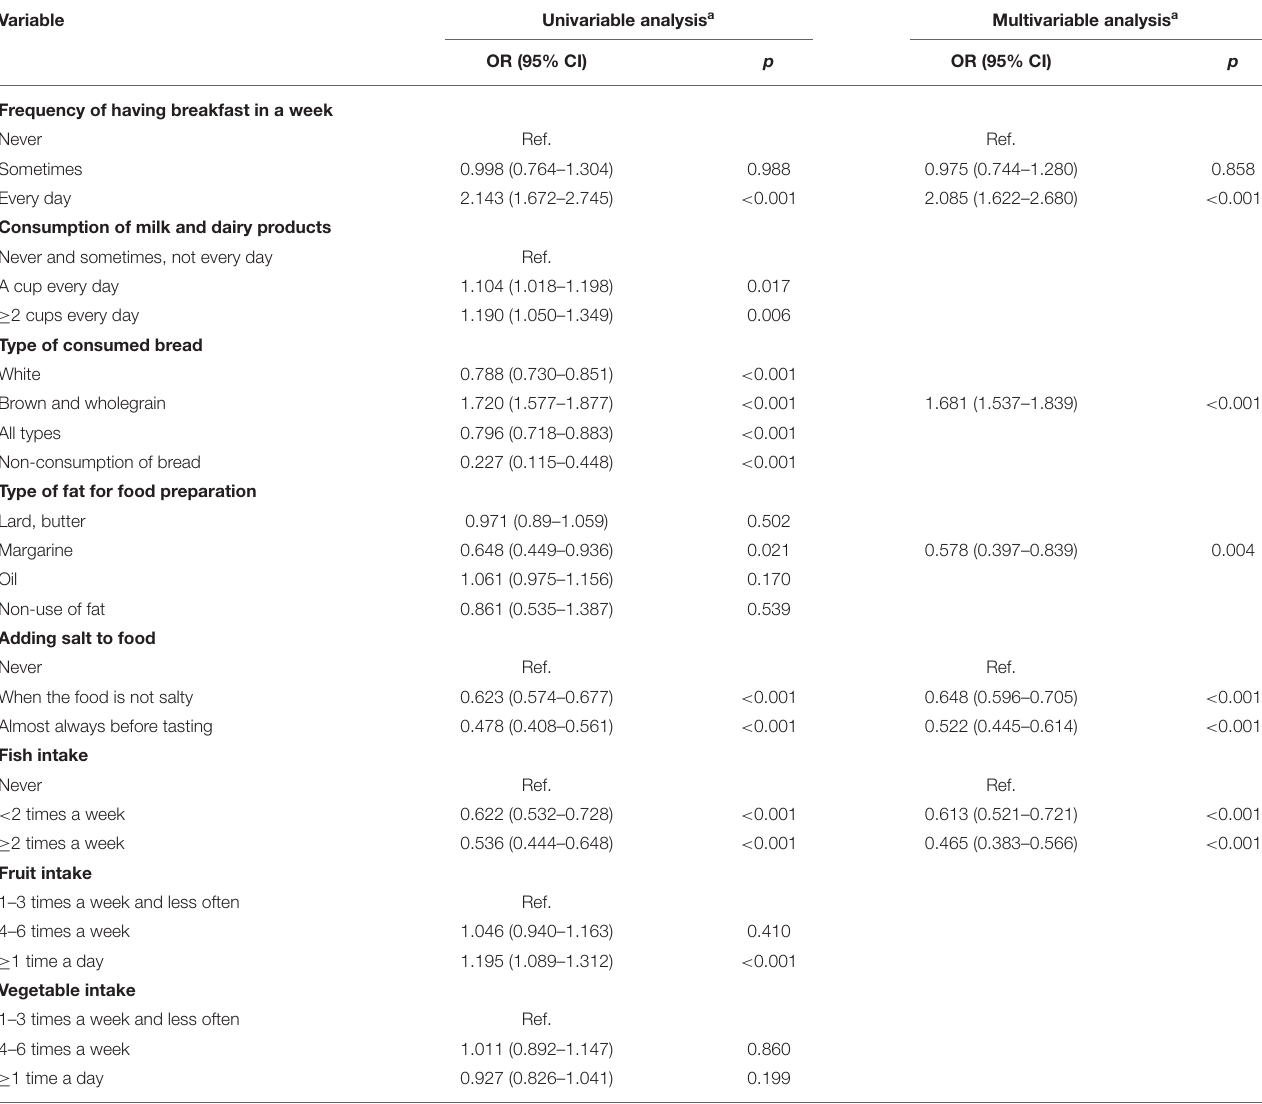
TABLE 3 | Dietary habits associated with older age group.